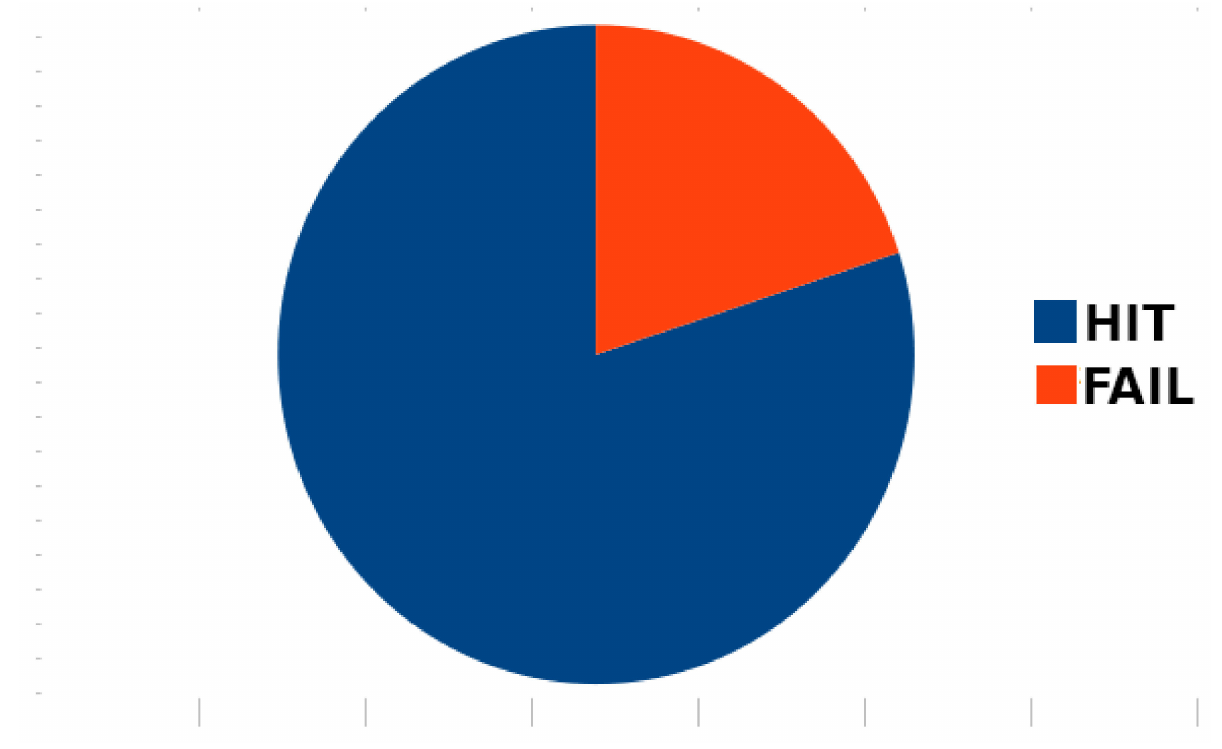
Figure 1. Game results. Table 2. Rules to be